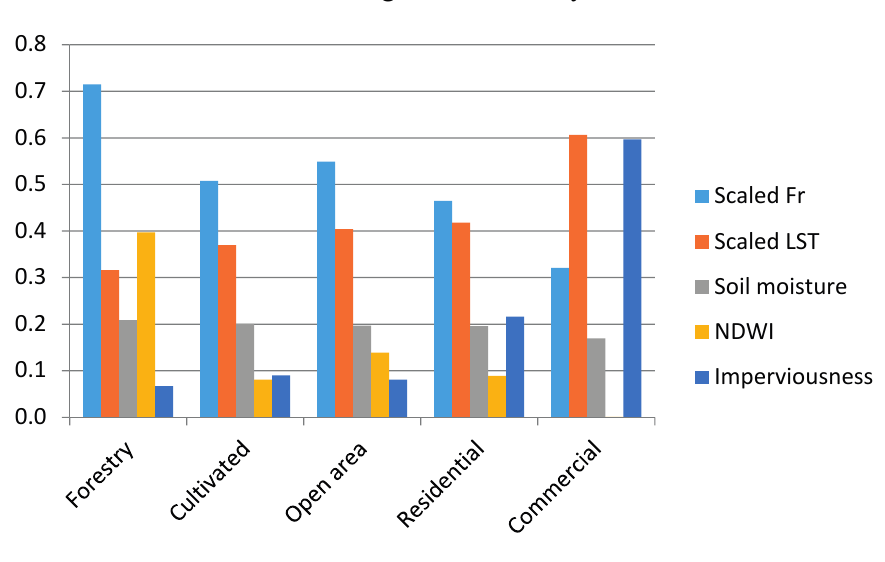
Figure 5. The characteristics measured by scaled vegetation fraction (Scaled Fr), scaled LST, soil moisture, NDWI and percentage of imperviousness for different land types in three sample areas on 17 June 2001 and 1 July